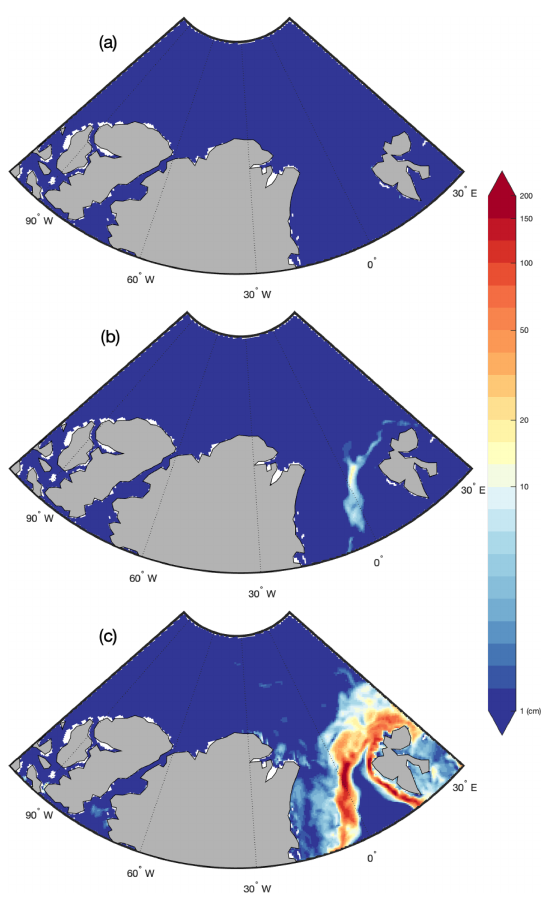
Figure 5. Monthly integrated sea ice melt terms over the northern Greenland region during February 2018 from the RASM hindcast simulation: (a) surface top, (b) lateral, and (c) basal melt